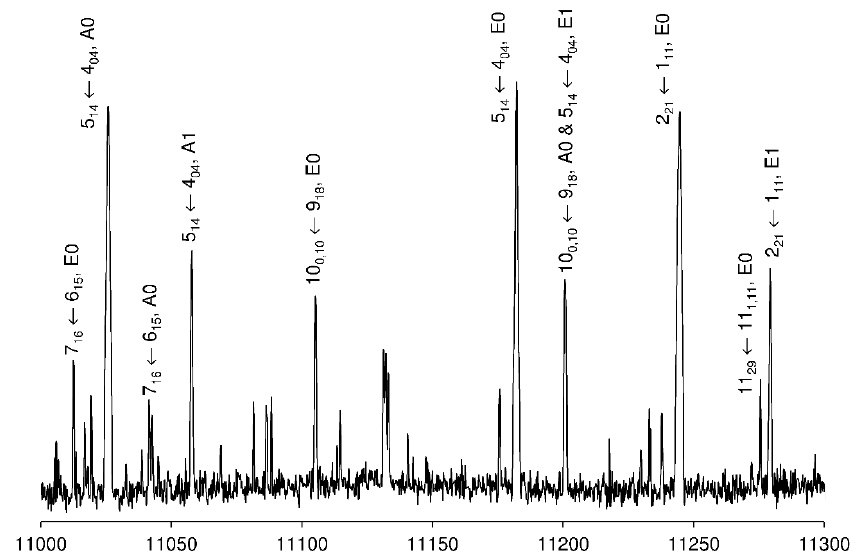
Figure 9. A portion of the scan of phenyl acetate in the frequency range from 11,000 to 11,300 MHz recorded by overlapping spectra with 50 co-added decays per each spectrum. The logarithmic intensities are in arbitrary units. The assigned lines are labeled with the corresponding rotational quantum numbers and tunneling species. Table 1. Molecular parameters obtained from a simultaneous fitting of the A0, A1, E0 and E1 sub-state lines of phenyl acetate using the program spfit